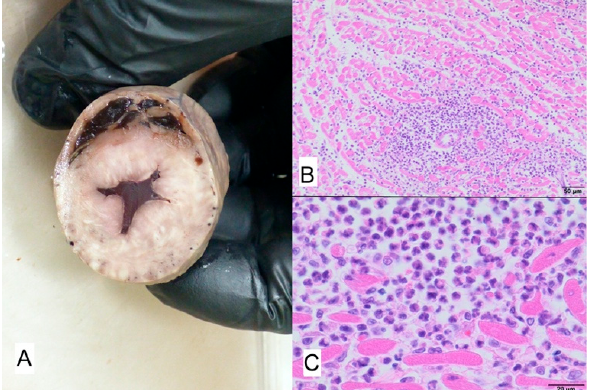
Figure 10. ( A ) Macroscopic view of transverse section of feline heart (specimen fixed in formalin) – numerous visible, randomly distributed, poorly demarcated, pale foci of inflammation; visible transverse section of blood vessels seen at the periphery of left ventricular wall. Microscopic view: ( B ) focal (perivascular) to diffuse inflammatory infiltrate between cardiomyocytes, Hematoxylin- eosin, magnification 40×. ( C ) Consisting mainly of neutrophils with few macrophages and magnifi- cation